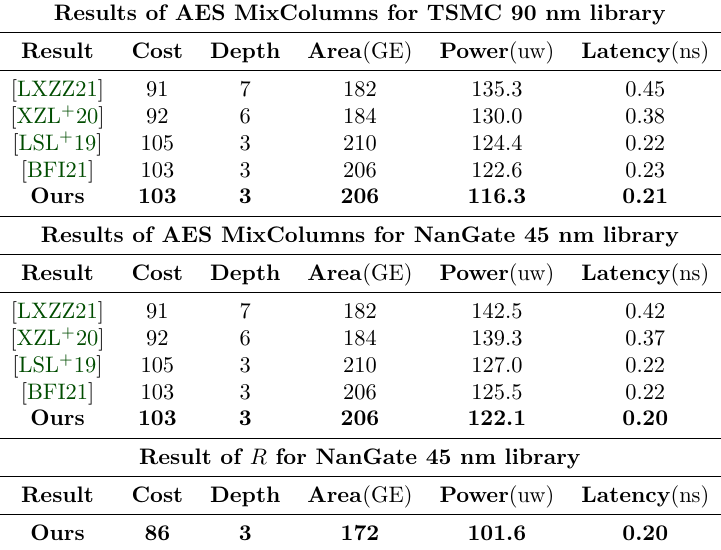
Table 9: Synthesized results using two different ASIC